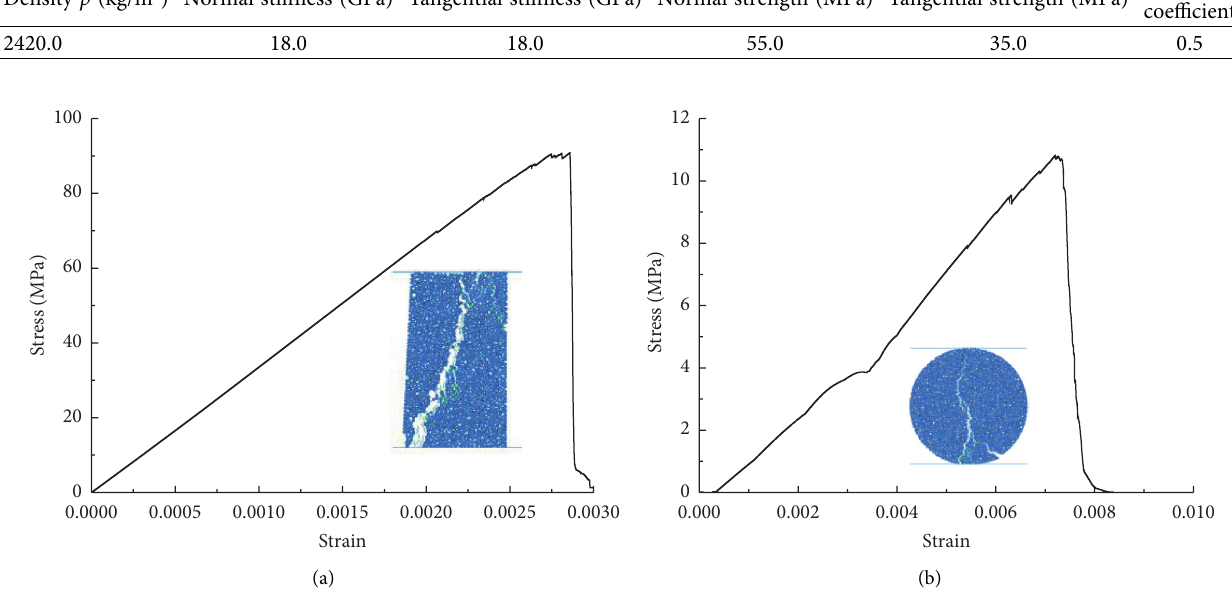
Figure 1: Calibration of mesoparameters of the particle flow model: (a) uniaxial compression compressive strength calibration; (b) Brazilian splitting tensile strength